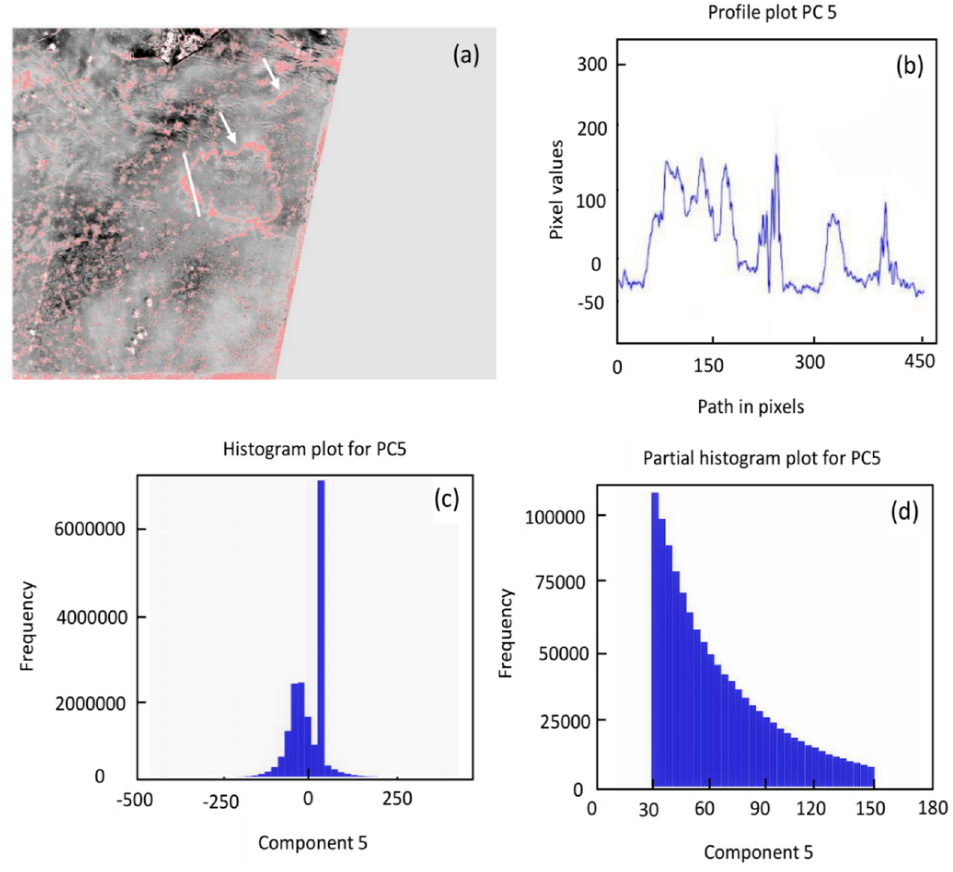
Figure 7. ( a ) The PCA component 5 estimated from Sentinel-2 bands on 7 September 2021, ( b ) Cross- section profile plot of component 5. 5, ( c ) Component 5 histogram, ( d ) Component 5 partial histogram for predefined values.